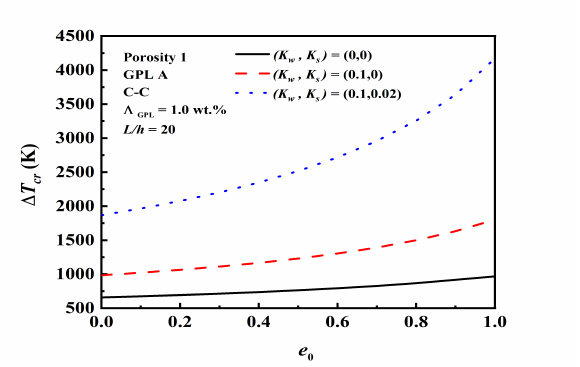
Figure 5. Effect of foundation stiffness for critical buckling temperature rise.